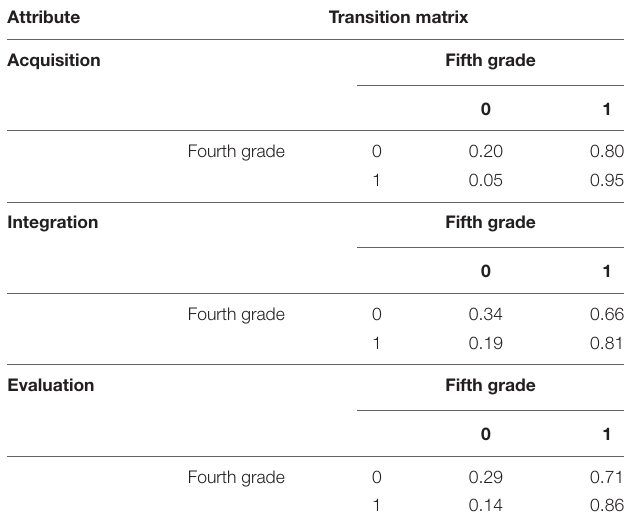
TABLE 9 | The transition probability matrix of attributes.